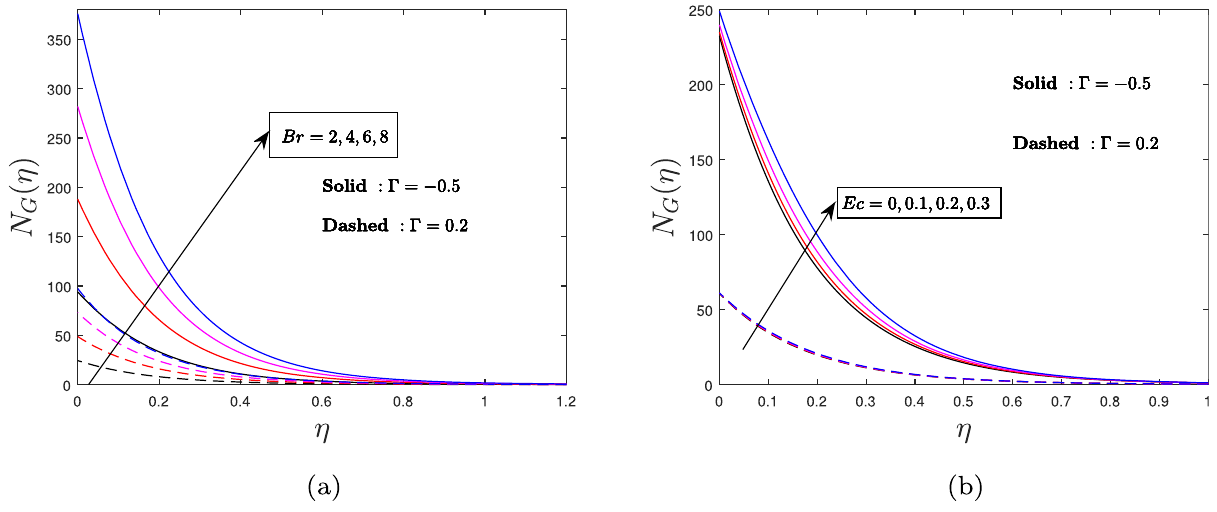
Figure 17: Entropy generation pro fi les against ( a ) Br and ( b )